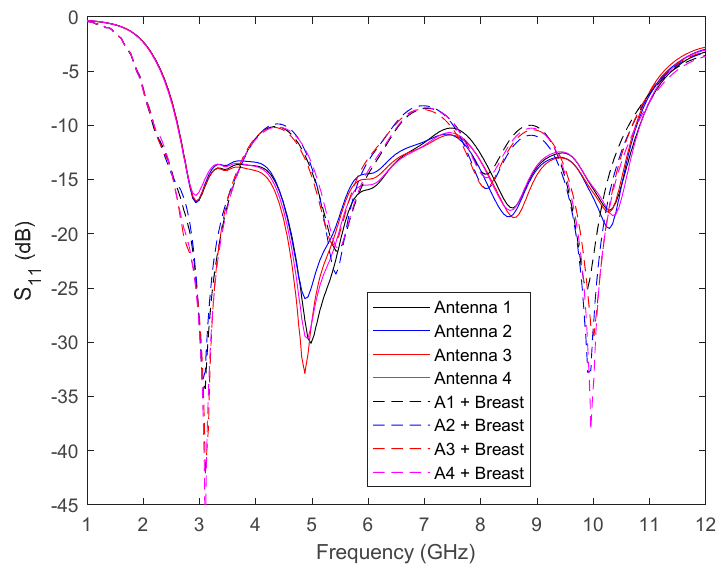
Figure 18. Antenna reflection coefficient with and without the breast model.